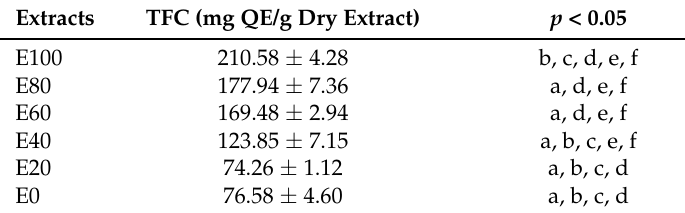
Table 3. TFC of extracts.